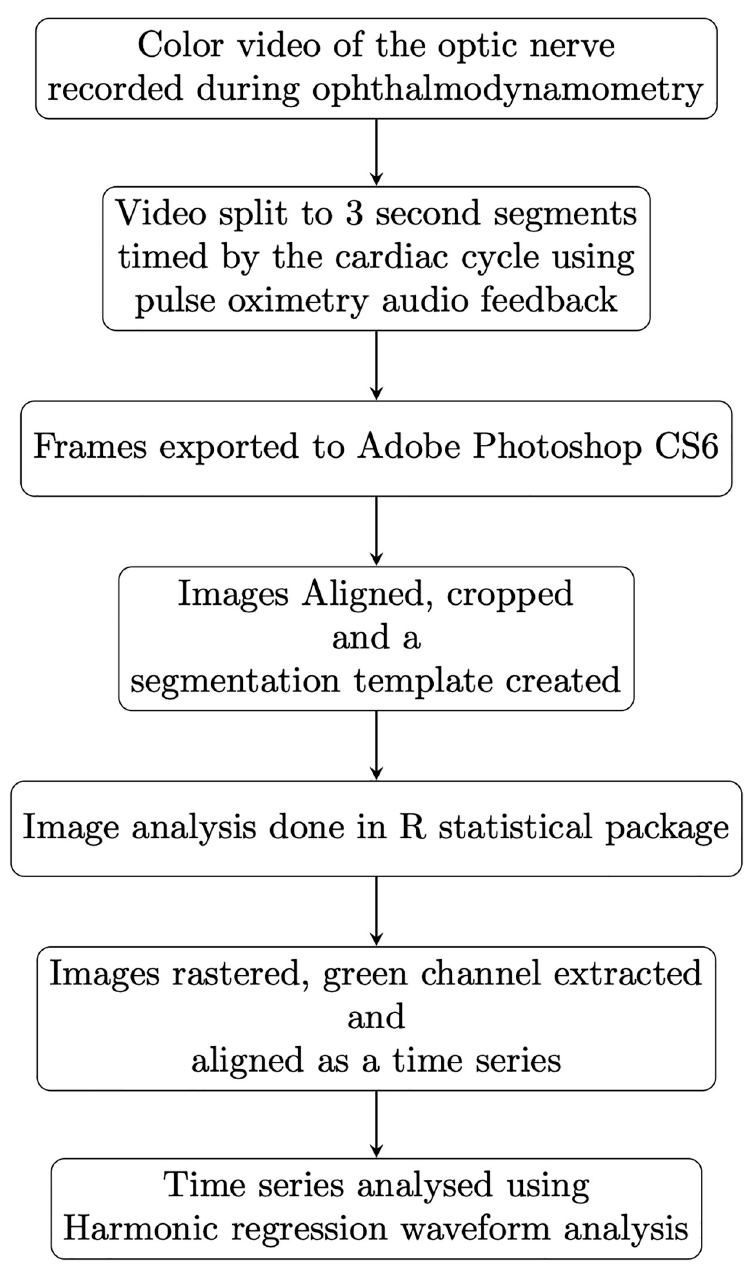
Fig 3. Summary workflow. Schematic of the technical workflow in the data acquisition and image processing.